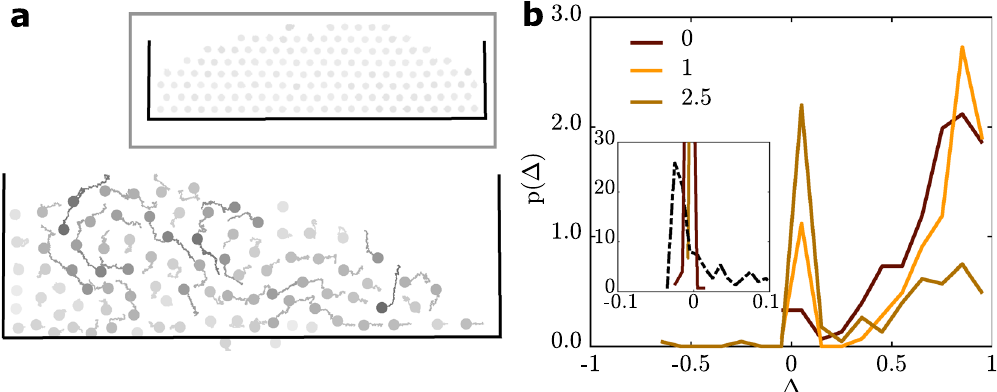
Figure 5. Particle dynamics. ( a ) Exemplary particle trajectories inside a rectangular confinement at β/β 0 = 1.25 in the experiment and in the simulation (inset) captured within 135s . The grayscale is proportional to the trajectory length, same scale for experiment and simulation. ( b ) Probability density function p (�) for particles in a confined group for experiment and simulation (inset). The line colours refer to values of β/β 0 . The dashed line in the inset corresponds to an effective temperature of c = 2.5 and β/β 0 = 0 , while the continuous lines refer to systems with c = 1 . See SI (Fig. S3) for the full measured